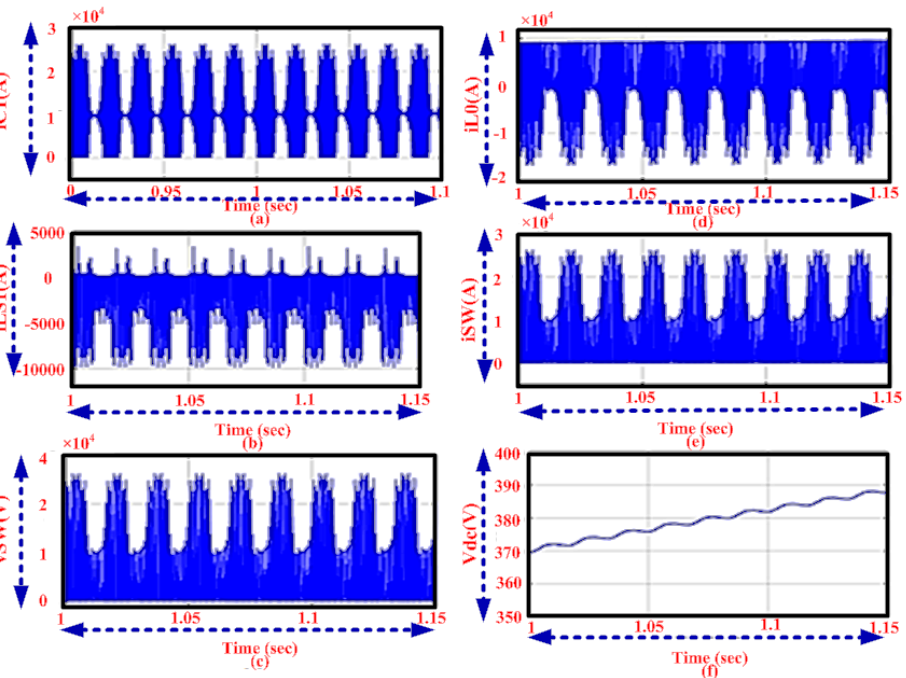
Figure 6. Analysis of current using the ( a ) C 1 , ( b ) L 1 , ( d ) L 0 , ( e ) switch and voltage using ( c ) switch, ( f ) DC link.